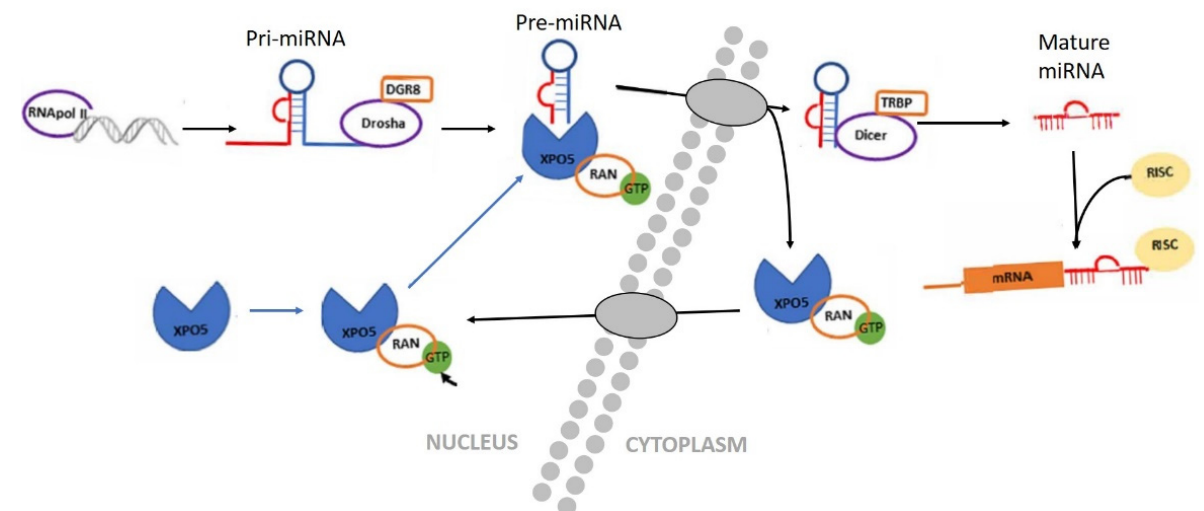
Figure 1. Diagram of miRNA biogenesis. In the nucleus, miRNA that are transcribed by RNA polymerase II or III as primary transcripts (pri-miRNA). The enzyme Drosha and its cofactor DGCR8/Pasha then cut the pri-miRNA molecule to form a pre-miRNA. This pre-miRNA is actively transported from the nucleus to the cytoplasm by the nuclear transport receptor Exportin 5 (XPO5) in a Ran-GTP (guanosine triphosphate) protein dependent manner by XPO5. In the cytoplasm, the pre-miRNA is cut by a second enzyme called Dicer, to form a mature and short double-stranded miRNA molecule. The miRNA duplex unwinds and is incorporated into the RISC protein complex [17].